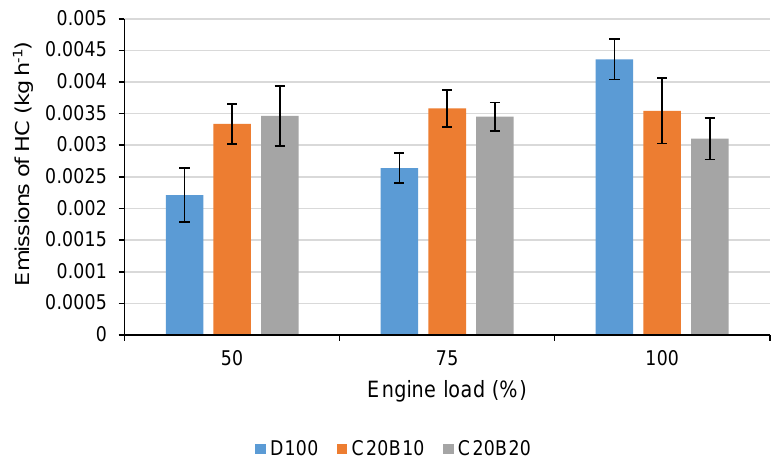
Figure 4. Emissions of HC in relation to engine load for all tested fuels (error bars represent the standard deviation).